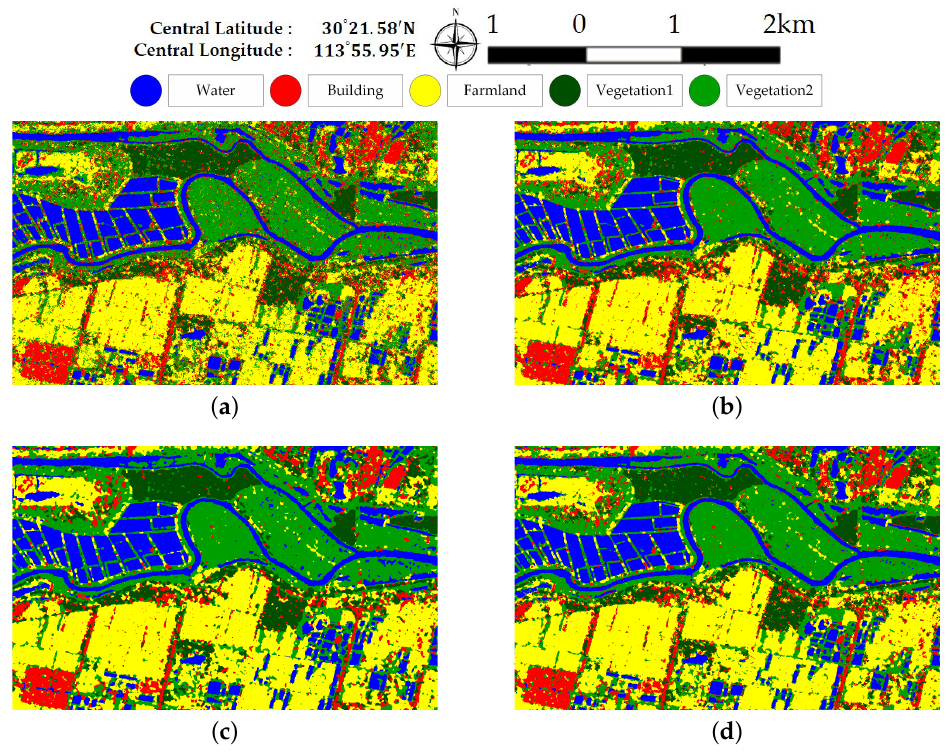
Figure 8. Classification maps of different classifiers on data set B. ( a ) Decision Tree. ( b ) Random Forest. ( c ) SVM. ( d ) XGBoost.